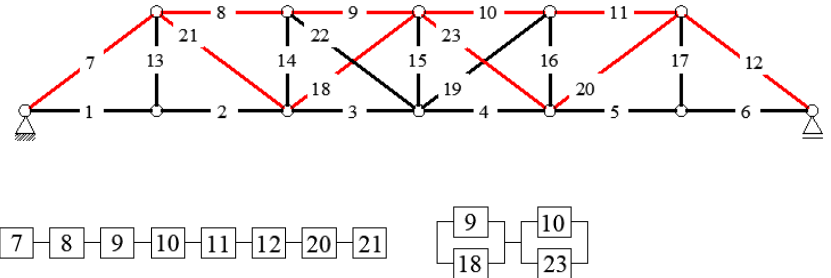
Figure 5. The new static scheme of the analyzed truss after 30 minutes of fire duration and corre- sponding cut-sets.